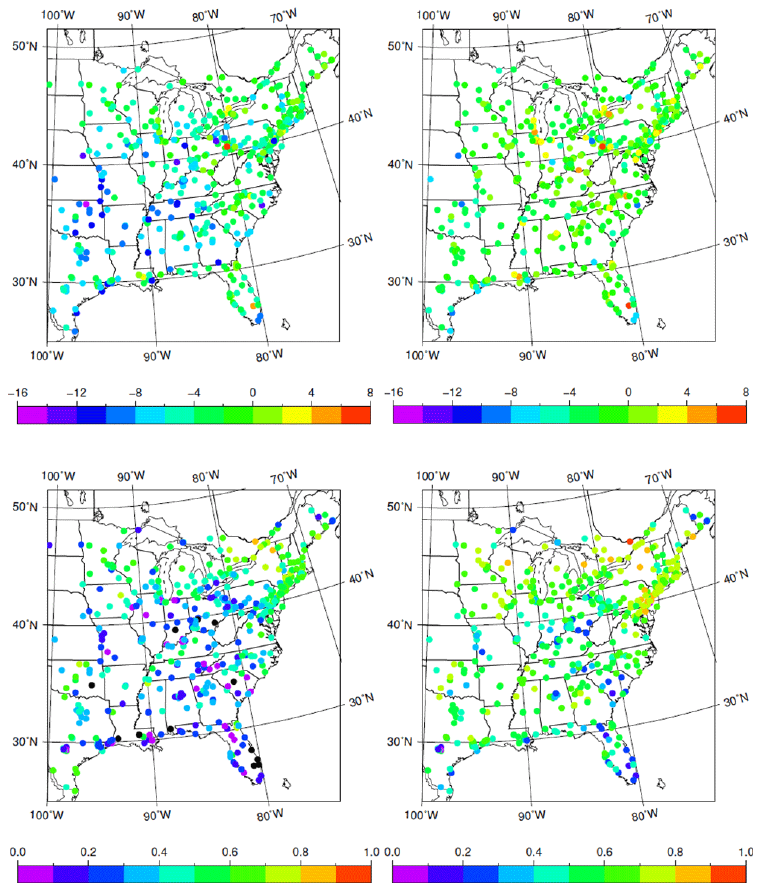
Figure 4. Bias (µgm − 3 ) (top) and temporal correlation (bottom) of forecasts for NoDA (left) and EnKF (right) simulations against AIRnow observations for the period 28 June–6 July 2012. Black dots denote negative correlations.